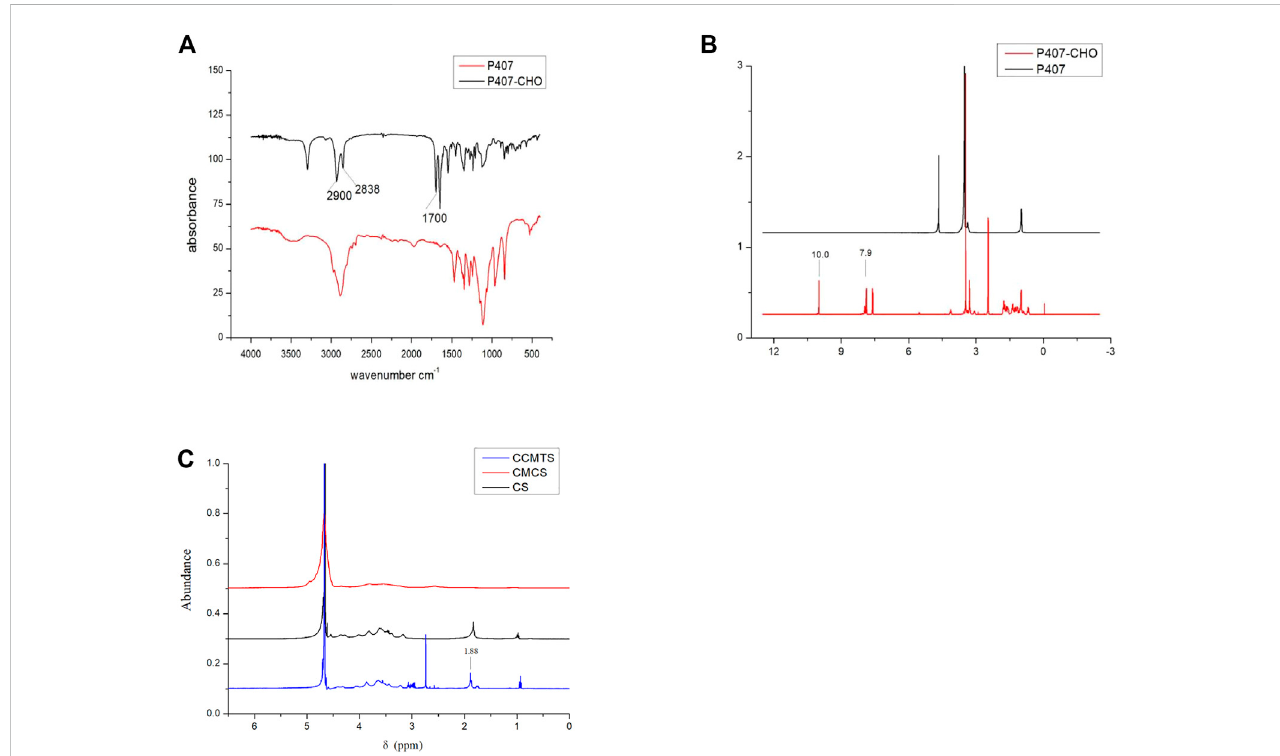
FIGURE 1 Structural analysis of P407-CHO and CCMTS. (A) FT-IR spectrum of P407 and P407-CHO. (B) 1 H NMR images of P407 and P407-CHO. (C) 1 H NMR images of CCMTS, CMCS, and CS.